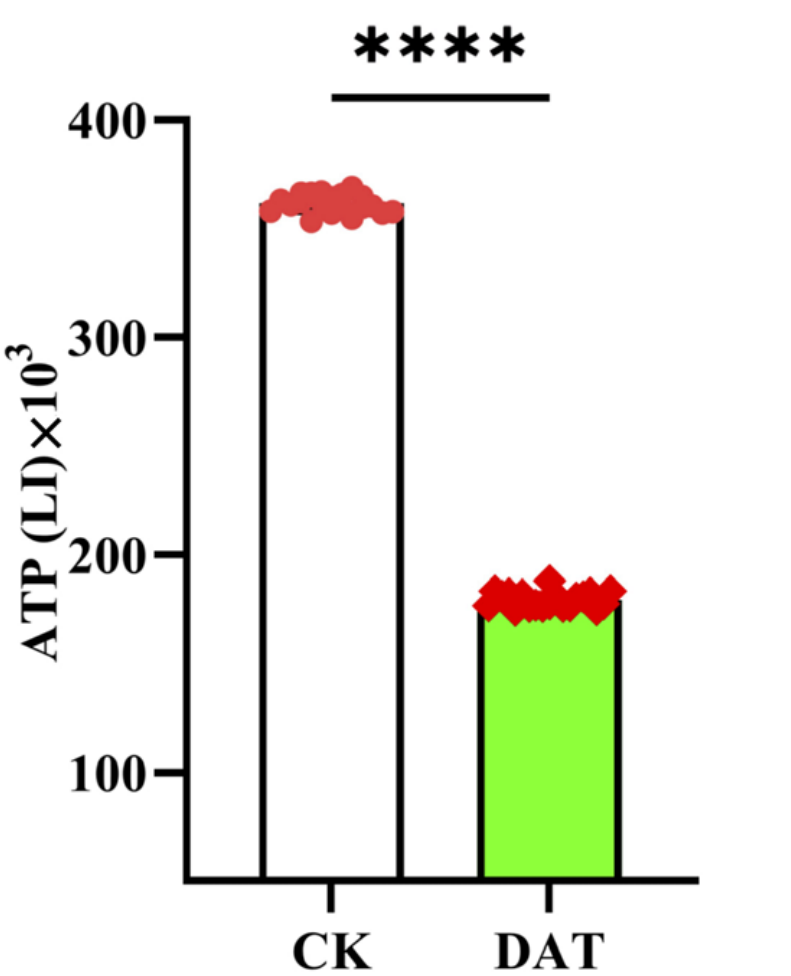
Figure 4. Rate of adenosine triphosphate (ATP) was measured in spermatozoa from seminal vesicles of control and DAT-fumigated male moths. The experiment was performed in triplicates with biological replicates and used a total of 50 male moths from each group. The data are represented as luminescence intensity (LI) (unpaired two-tailed t -test, **** p < 0.0001). Lipid and cholesterol homeostasis are vital for male fertility and reflect sperm con- centration and motility. Because the DAT significantly decreased the sperm motility and related parameters, we examined the lipid contents in the fat bodies of the control and DAT-fumigated moths using a fluorescence assay. The fat-body particles in the control moths were tightly arranged and large (Figure 5A, CK); however, after the DAT exposure, the fat bodies had weak fluorescence and empty spaces, with small fat-body particles ( p < 0.001; Figure 5A, DAT panel and B), which means that the lipid contents decreased after treatment (Figure 5B). We further checked for triacylglycerol and total cholesterol content in the controls and the DAT-treated male moths (Figure 5C,D). The results showed that a reduction in the content of triacylglycerol was found in the DAT-treated males and the difference was significant compared with the controls ( p < 0.05, df = 4, F = 2.489). However, no significant changes were seen in the total cholesterol content between the controls and the treated groups (Figure